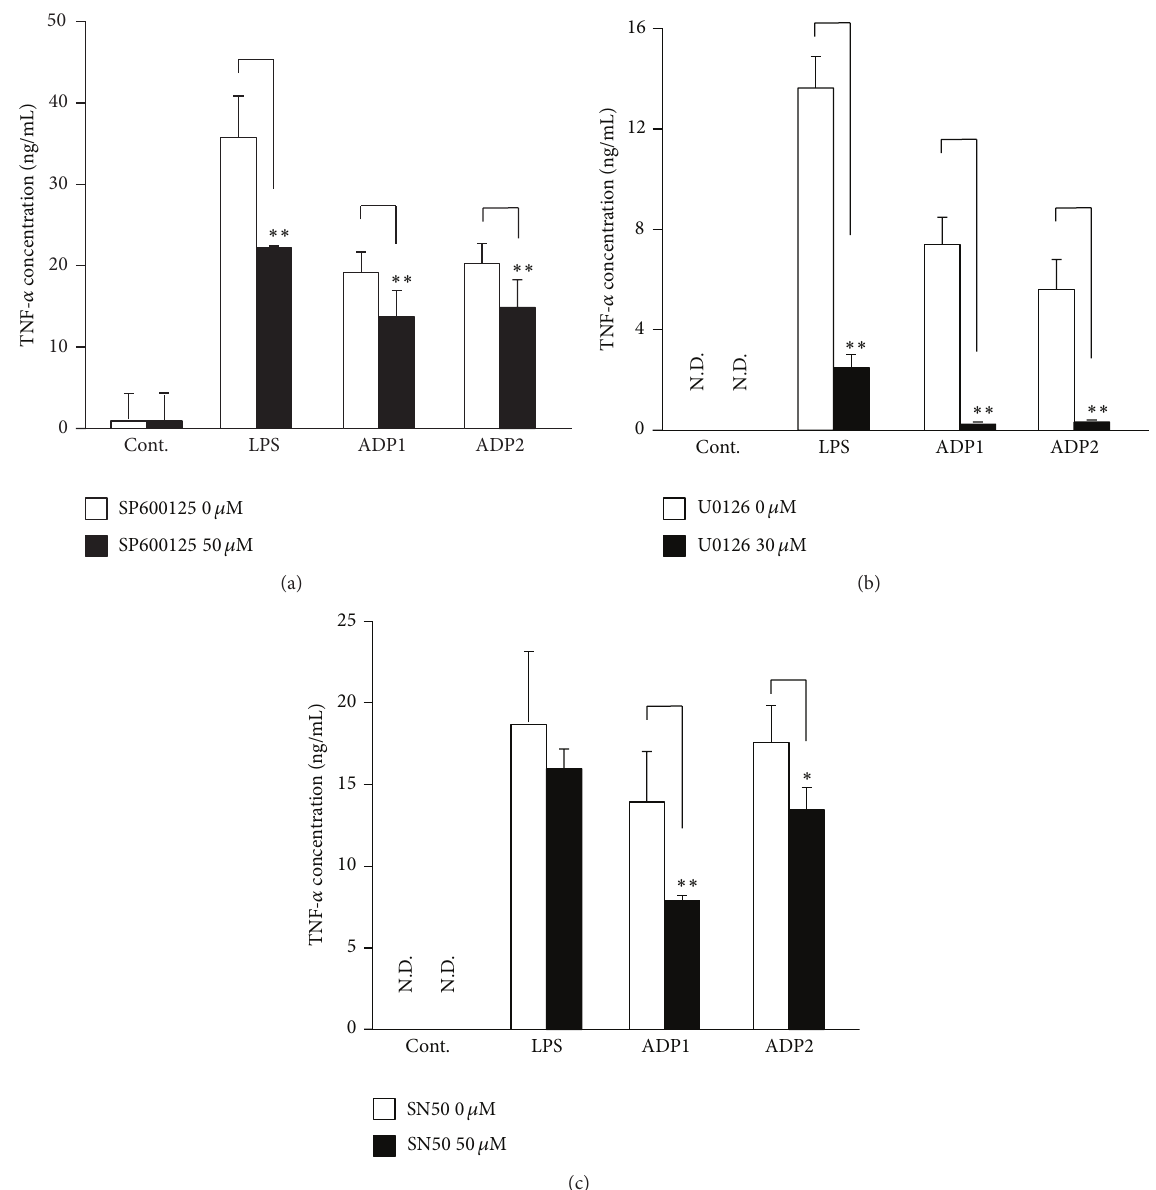
Figure 5: Asian dust particles-induced tumor necrosis factor- 𝛼 (TNF- 𝛼 ) production is dependent on mitogen-activated protein kinase and nuclearfactor- 𝜅 Bsignalingpathways.RAW264.7cellswerepretreatedfor30 minwith(a)50 𝜇 MofSP600125,aninhibitorofc-JunN-terminal kinase; (b) 30 𝜇 M of U0126, an extracellular signal-regulated kinase (ERK) inhibitor; or (c) 50 𝜇 M of SN50, a nuclear factor- 𝜅 B (NF- 𝜅 B) inhibitor and then treated for 6 h with 100 𝜇 g/mL of ADP1 or ADP2 or 1.5 𝜇 g/mL of LPS. Dimethyl sulfoxide (0.1%) vehicle was used